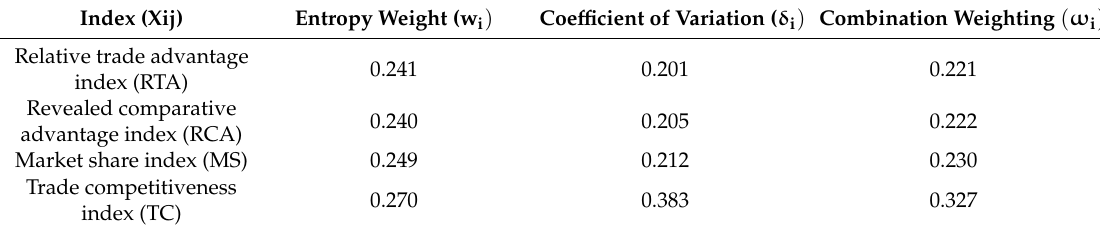
Table 2. The results of the weight combinations (with γ = 0.5 )